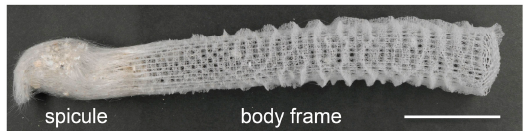
Figure 1. Photograph of the skeleton of Euplectella aspergillum. Scale bar is 5 cm.